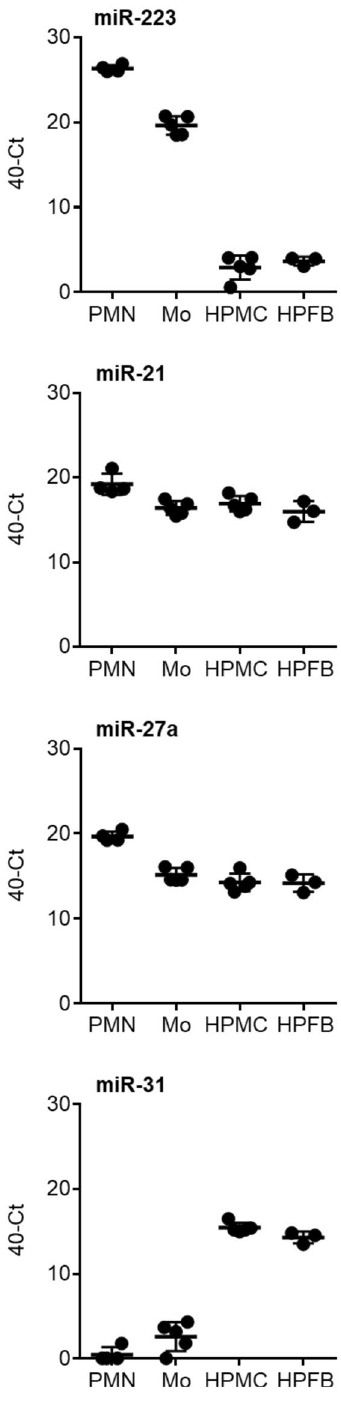
Figure 4. Cellular source of peritoneal microRNAs. Expression of microRNAs upon in vitro culture for 4 hours of neutrophils (PMN, n = 4) and monocytes (Mo, n = 5) from human blood and mesothelial cells (HPMC, n = 5) and fibroblasts (HPFB, n = 3) from human omentum. Each data point corresponds to an individual donor; lines indicate means and standard